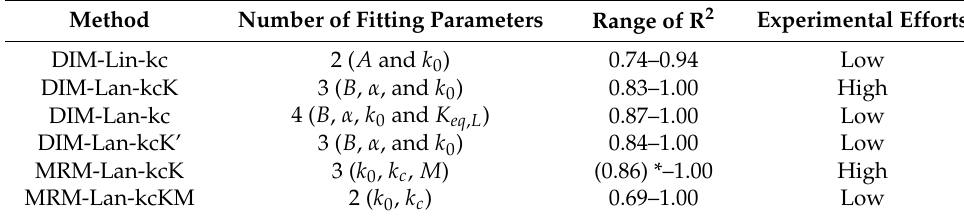
Table 3. Comparison of methods based on DIMs an